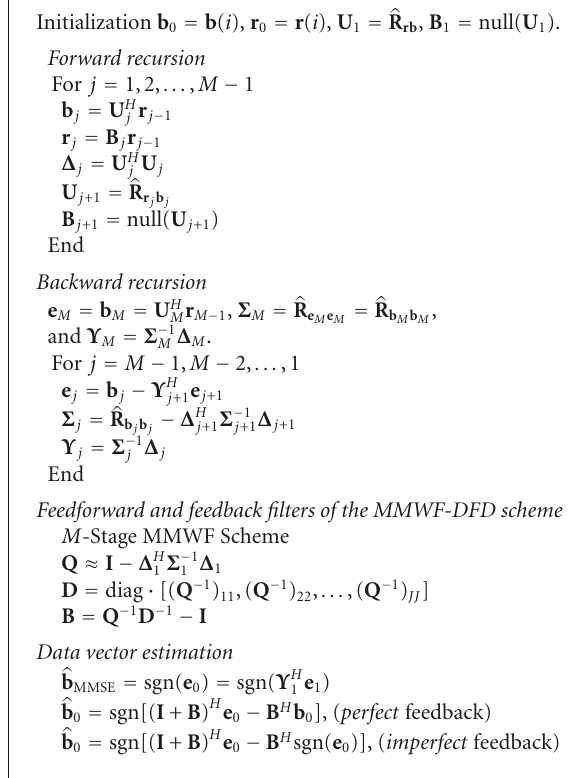
Algorithm 1: Recursion equations for the M -stage MMWF/ MMWF-DFD